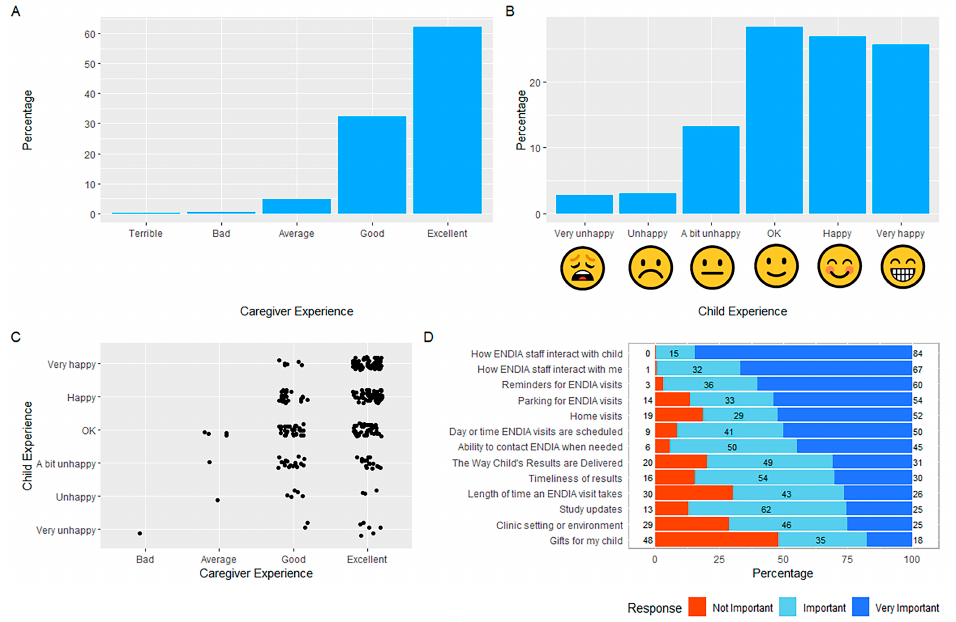
Figure 2. Overall experience ratings for ( A ) the Caregiver Survey, and ( B ) the Child Survey. ( C ) Correlated caregiver-child responses for overall experience ratings. ( D ) Responses to “How important have the following parts of the study been for your experience in ENDIA?”